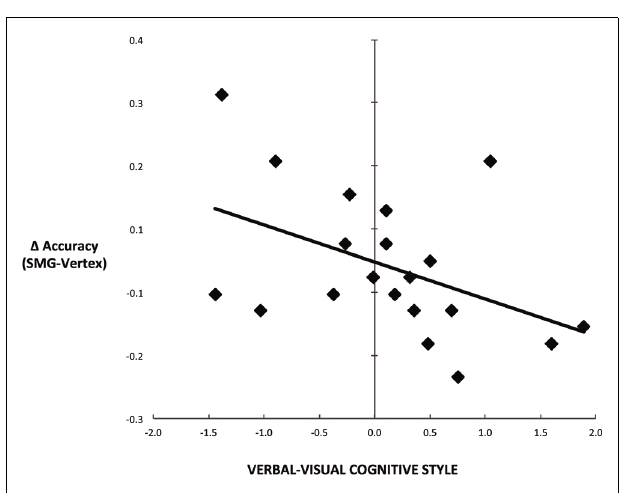
FIGURE 4 | Scatter plot depicting the correlation between cognitive style difference score (verbal–visual) and the decline in task performance for the picture–word condition as a result of left SMG rTMS ( r = − 0.46, p =